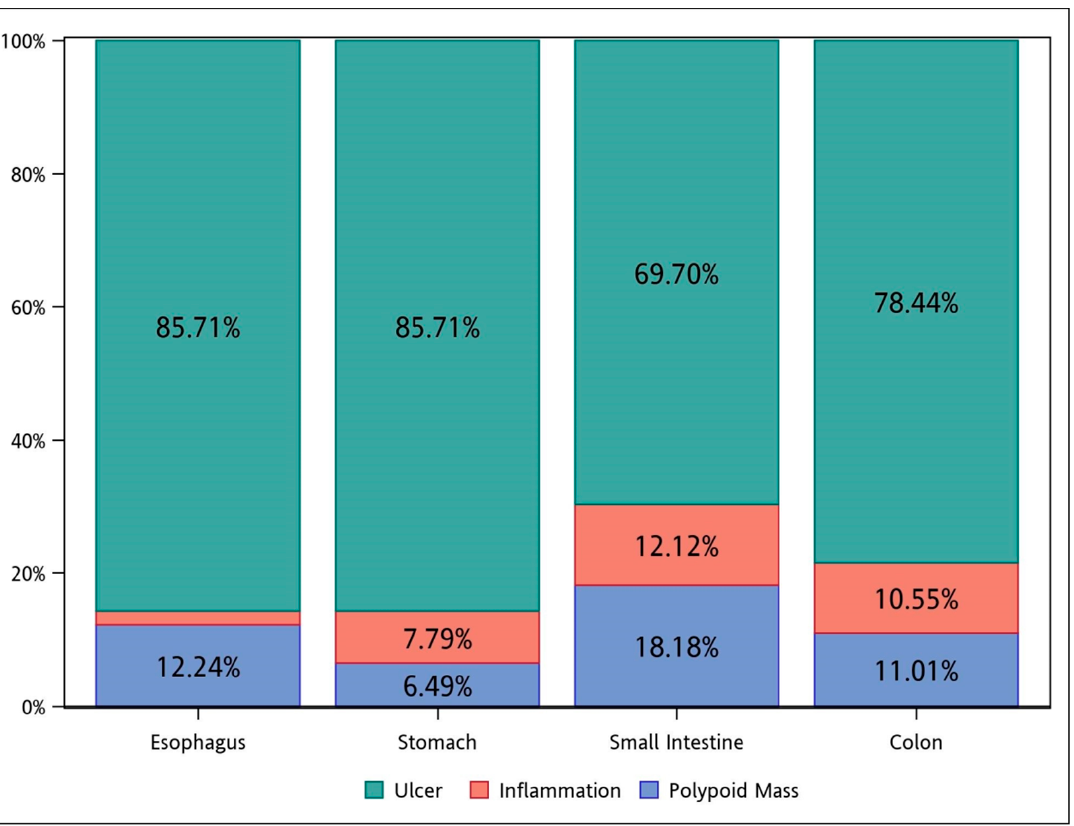
Figure 2. The endoscopic features of CMV diseases in different segments of the GI tract. CMV, cytomegalovirus; GI, gastrointestinal.